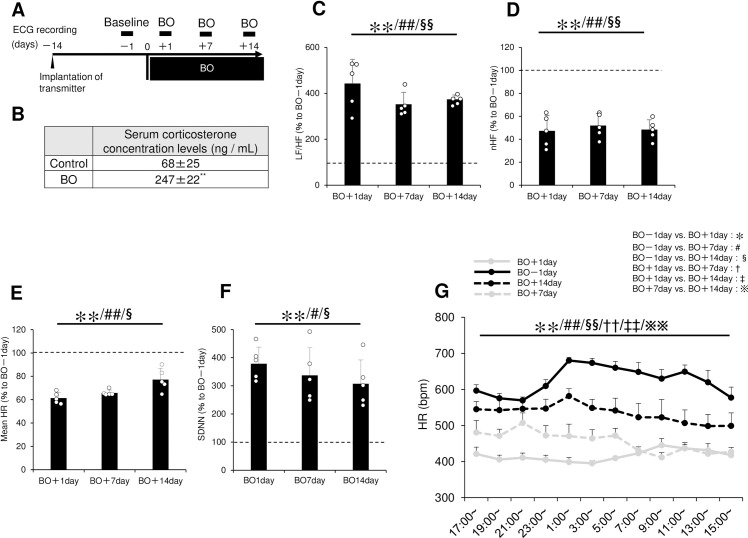
Effects of BO on serum corticosterone levels, LF/HF, nHF, mean HR and HRV.(A) ECG was recorded for 24 h at 1 day before the BO treatment (Baseline; BO-1day) and at 1, 7 and 14 days after the BO treatment (BO). (B) Serum corticosterone level was significantly increased by the BO treatment for 14 days, compared to the control group. **P < 0.01 by Student t-test (S3A Fig of S1 Data). (C) LF/HF, an index of the sympathetic nervous activity, was significantly greater at all time points in the BO group, compared to the baseline. **P < 0.01 (BO-1day vs. BO+1day), ##P < 0.01 (BO–1day vs. BO+7day), §§P < 0.01 (BO–1day vs. BO+14day) by one-way repeated-measures ANOVA followed by the Bonferroni post hoc test (S3B Fig of S1 Data). (D) nHF, an index of parasympathetic activity, was significantly smaller at all time points in the BO group, compared to the baseline. **P < 0.01 (BO-1day vs. BO+1day), ##P < 0.01 (BO–1day vs. BO+7day), §§P < 0.01 (BO–1day vs. BO+14day) by one-way repeated-measures ANOVA followed by the Bonferroni post hoc test (S3C Fig of S1 Data). (E) Mean HR was significantly smaller at all time points in the BO group, compared to the baseline. **P < 0.01 (BO-1day vs. BO+1day), ##P < 0.01 (BO–1day vs. BO+7day), §§P < 0.05 (BO–1day vs. BO+14day) by one-way repeated-measures ANOVA followed by the Bonferroni post hoc test (S3D Fig of S1 Data). (F) SDNN was significantly greater at all time points in the BO group, compared to the baseline. **P < 0.01 (BO-1day vs. BO+1day), ##P < 0.01 (BO–1day vs. BO+7day), §§P < 0.05 (BO–1day vs. BO+14day) by one-way repeated-measures ANOVA followed by the Bonferroni post hoc test (S4A Fig of S1 Data). (G) Time course changes in heart rate during 24 h of ECG measurement at 1 day before and 1, 7 and 14 days after BO treatment. **P < 0.01 (BO-1day vs. BO+1day), ##P < 0.01 (BO–1day vs. BO+7day), §§P < 0.01 (BO–1day vs. BO+14day), ††P < 0.01 (BO+1day vs. BO+7day), ‡‡P < 0.01 (BO+1day vs. BO+14day) and ※※P < 0.01 (BO+7day vs. BO+14day) by two-way repeated-measures ANOVA followed by the Bonferroni post hoc test (S4B of S1 Data).